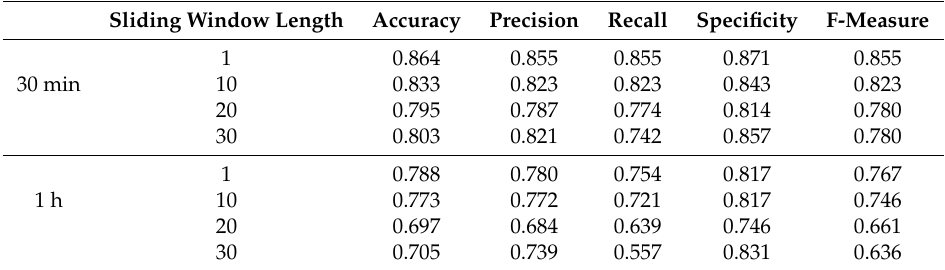
Table A1. Accuracy, precision, recall, specificity and F-measure of MLP classifiers in dataset with different sliding